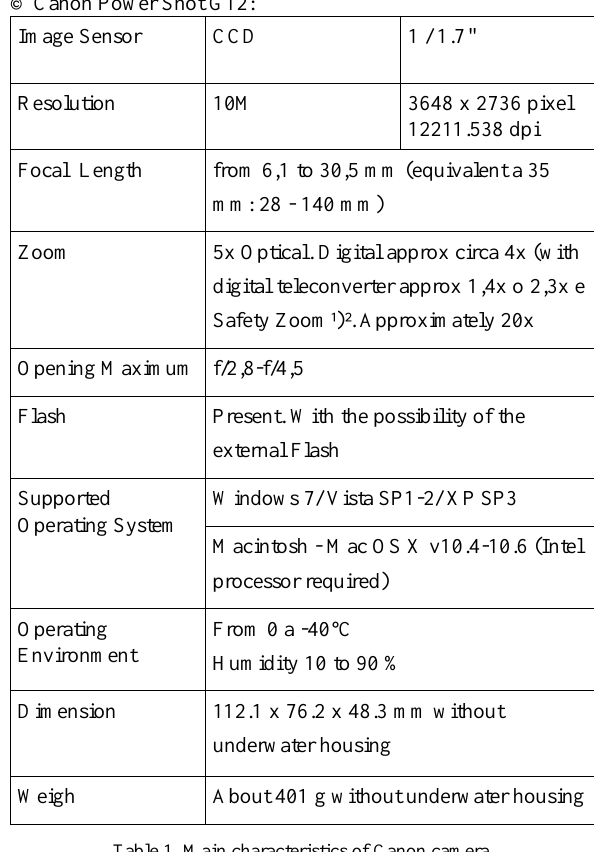
Figure 2. Dressel Table